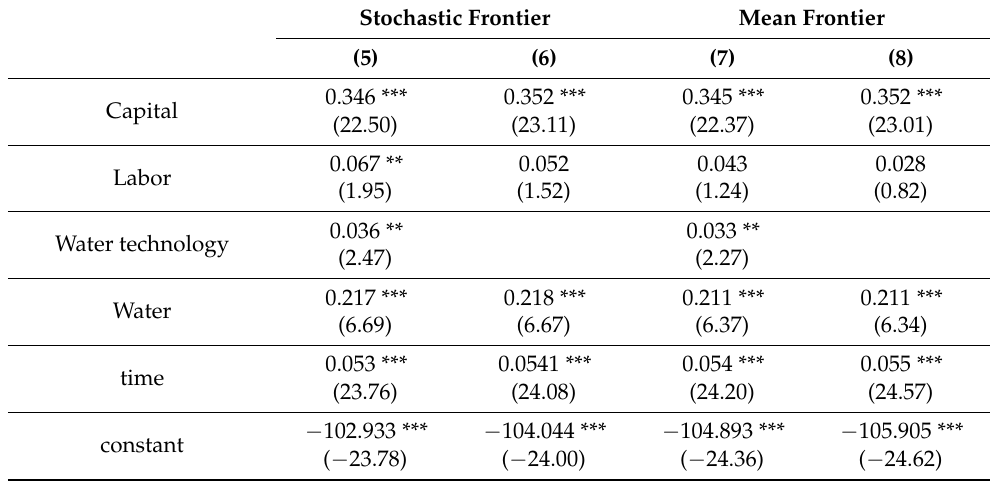
Table 4. Econometric estimates of water-saving